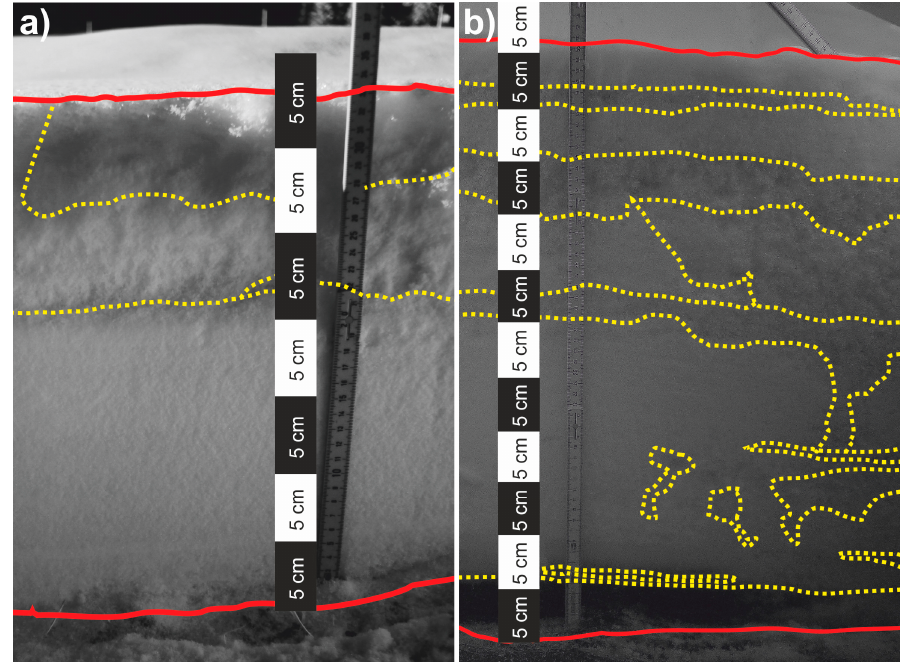
Figure 3. NIR photos of the snowpack profile taken on ( a ) 9 January and ( b ) 27 February. In addition and types can be observed in the second